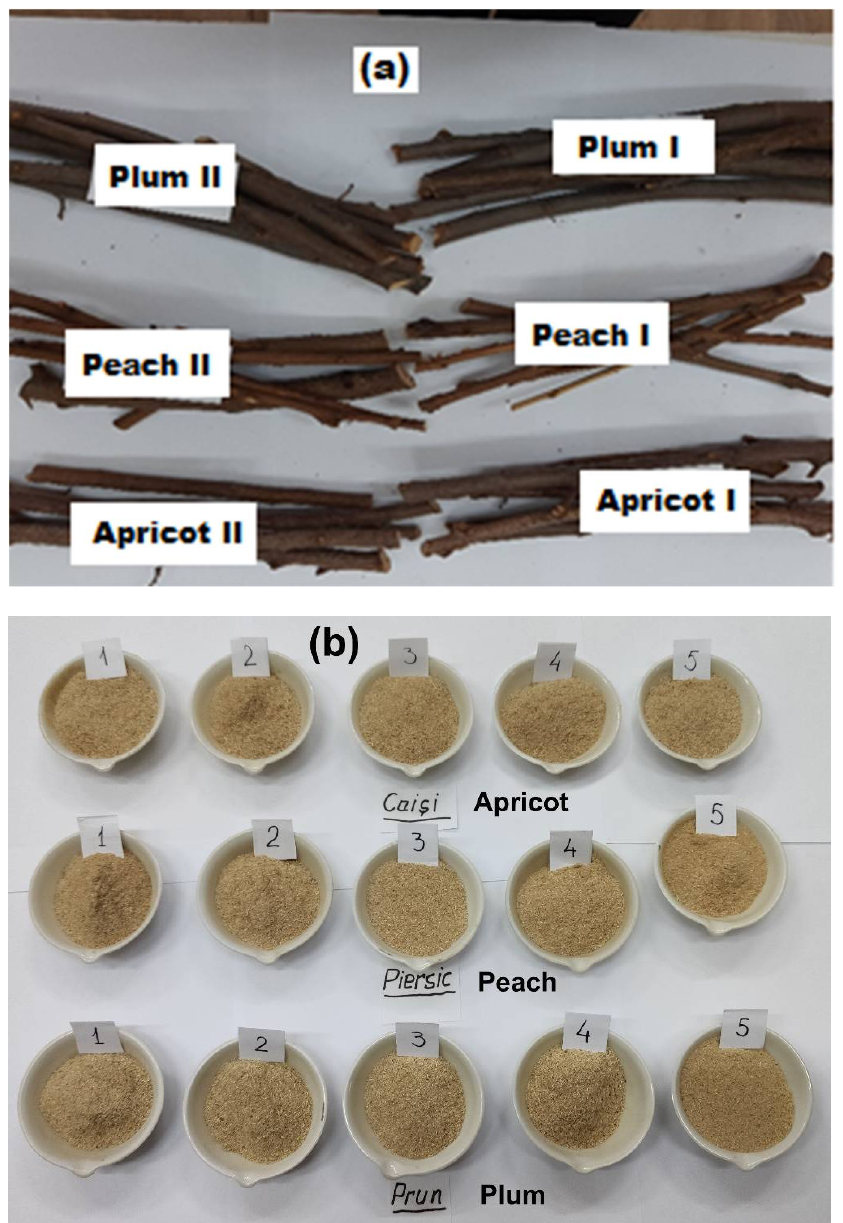
Figure 1. Biomass samples used in this research: ( a ) pruning residues; ( b ) shredded biomass samples.